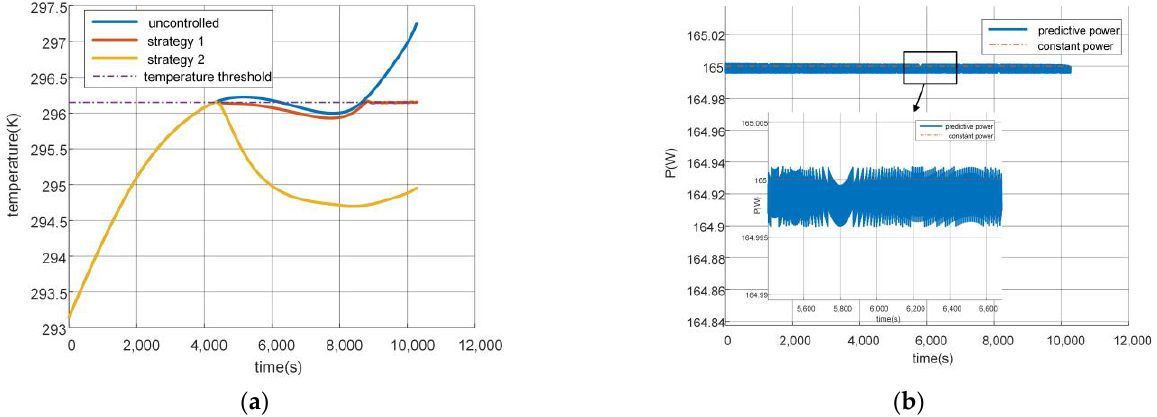
Figure 14. 165 W constant-power condition. ( a ) Temperature contrast. ( b ) Power comparison.